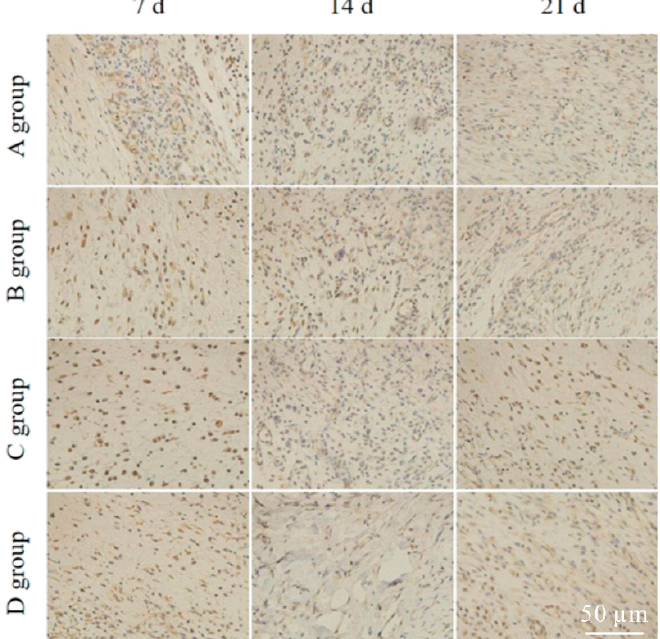
Figure 4. Expression results of bFGF at different time points. Notes: ( A ): model group; ( B ): dracorhodin perchlorate inflammation targeting emulsion gel group; ( C ): dracorhodin perchlorate non-targeting emulsion gel group; ( D ): positive group. Scale bar is 50 μ m.